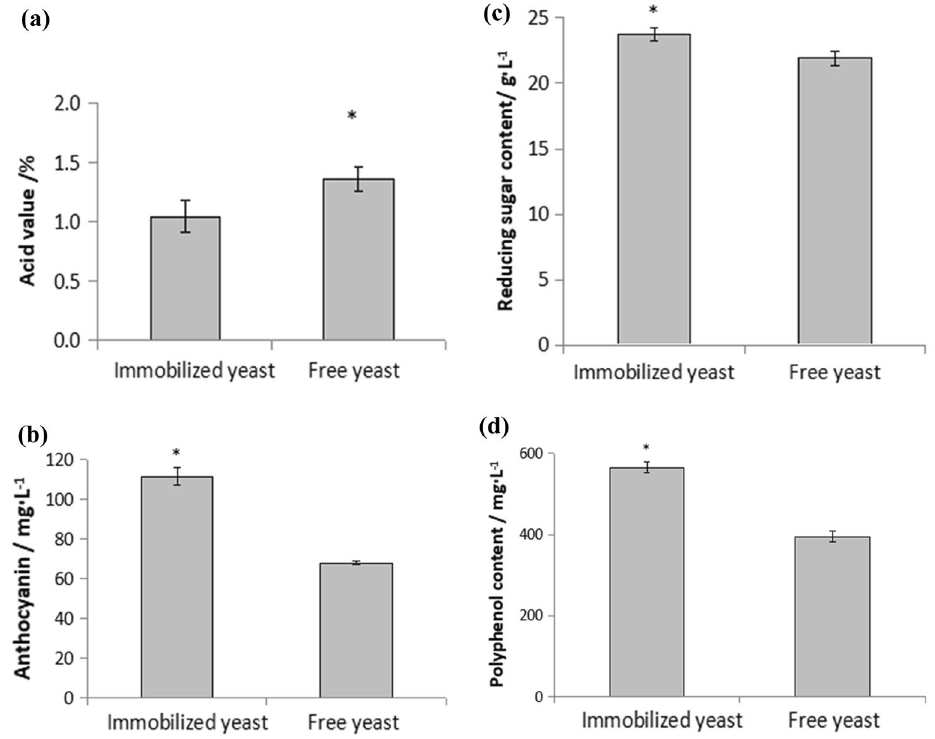
Figure 3. ( a ) Comparison of acid value between immobilized yeast and free yeast. ( b ) Comparison of anthocyanin content between immobilized yeast and free yeast. ( c ) Comparison of reducing sugar between free yeast and immobilized yeast. ( d ) Comparison of polyphenol content between free yeast and immobilized yeast.